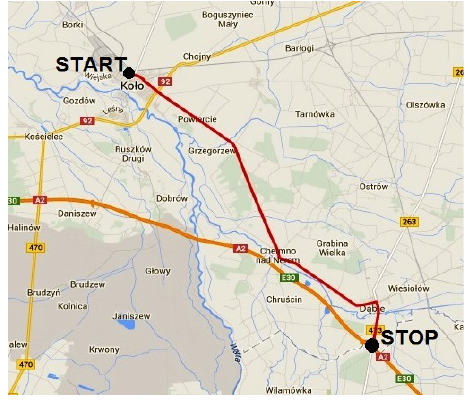
Fig. 1. The test route used in the on-road emission test of a heavy-duty vehicle [10]